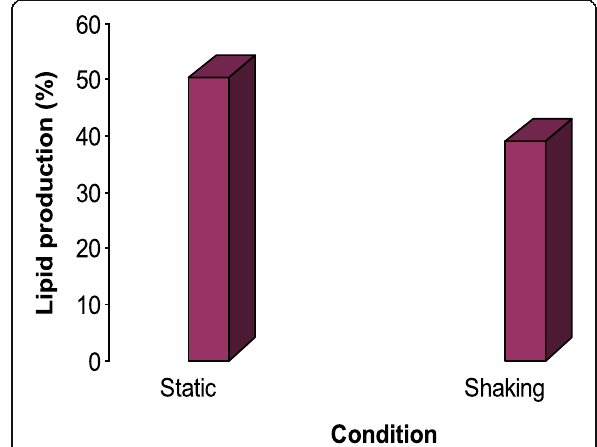
Fig. 7 Effect of static and shaking conditions on F. oxysporum NRC 2017 lipid production